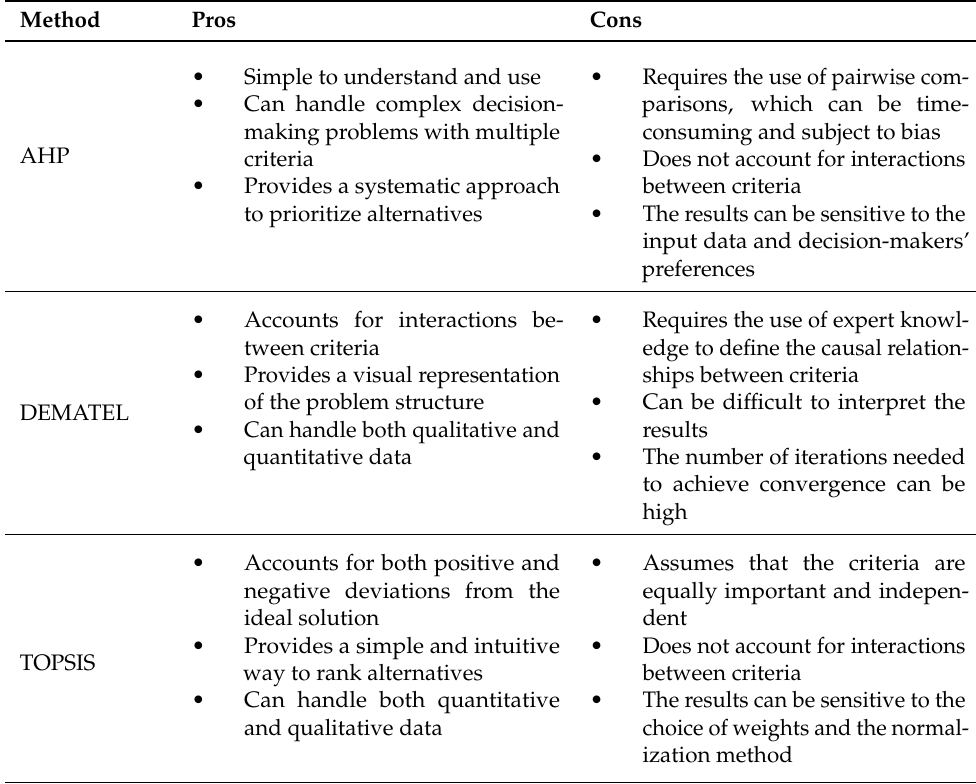
Table 4. Pros and cons of AHP, DEMATEL, and TOPSIS